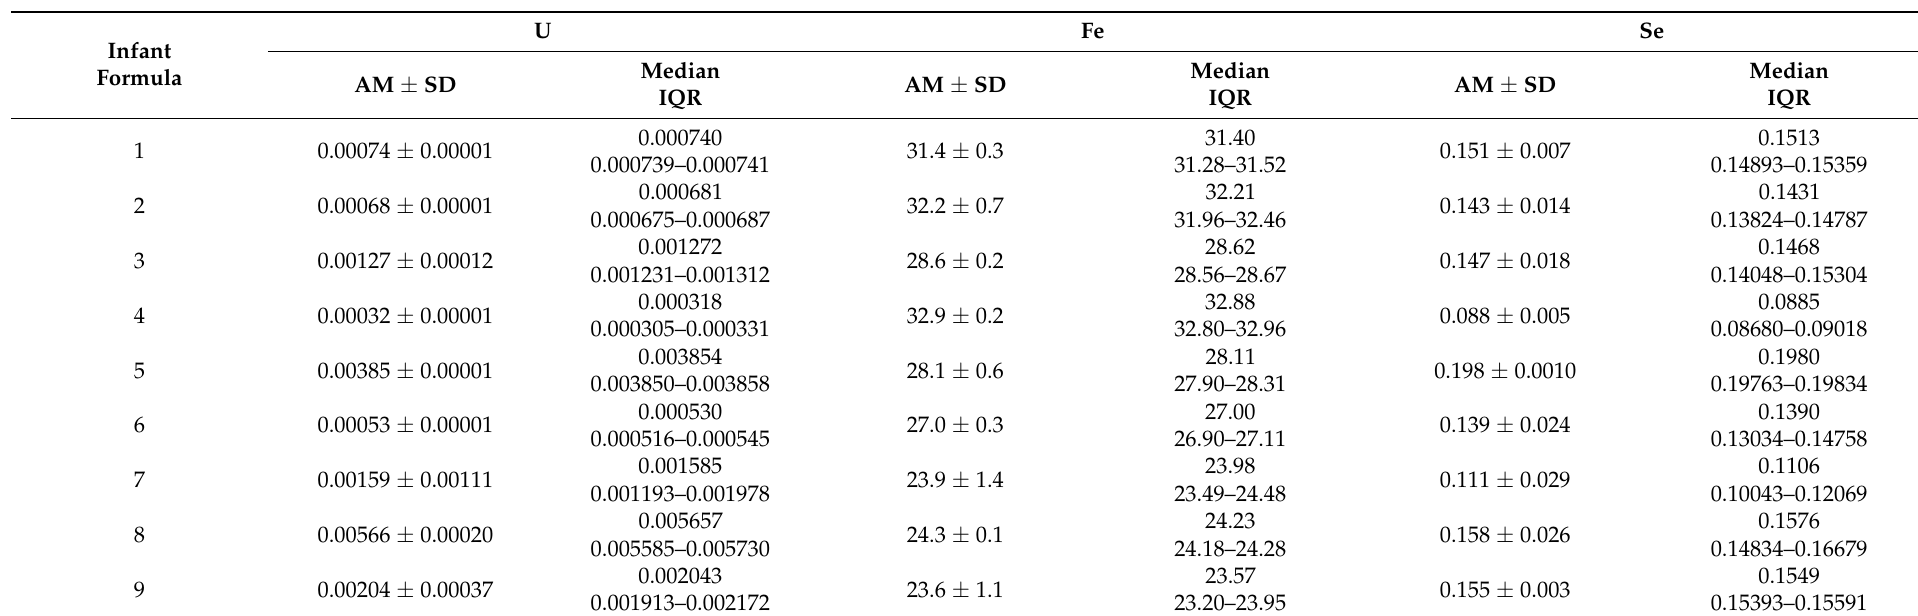
Table 6. Descriptive statistics of U, Fe and Se calculated on a total of 12 determinations for each formula and expressed as µ g g − 1